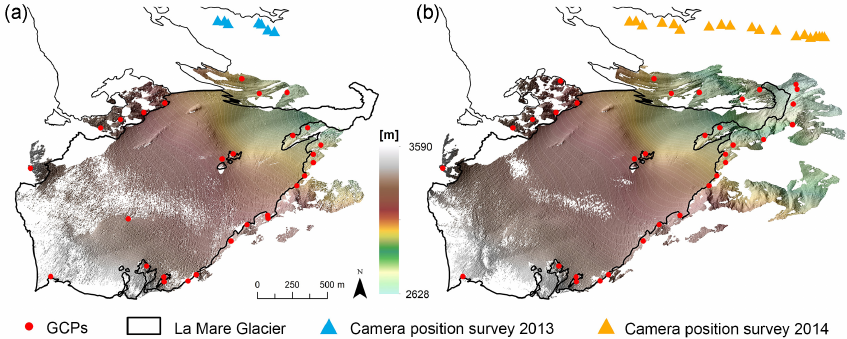
Figure 5. Hillshaded DEMs with superposed semi-transparent colour map of La Mare Glacier derived from photogrammetric measurements for (a) 4 September 2013 and (b) 27 September 2014 image surveys.